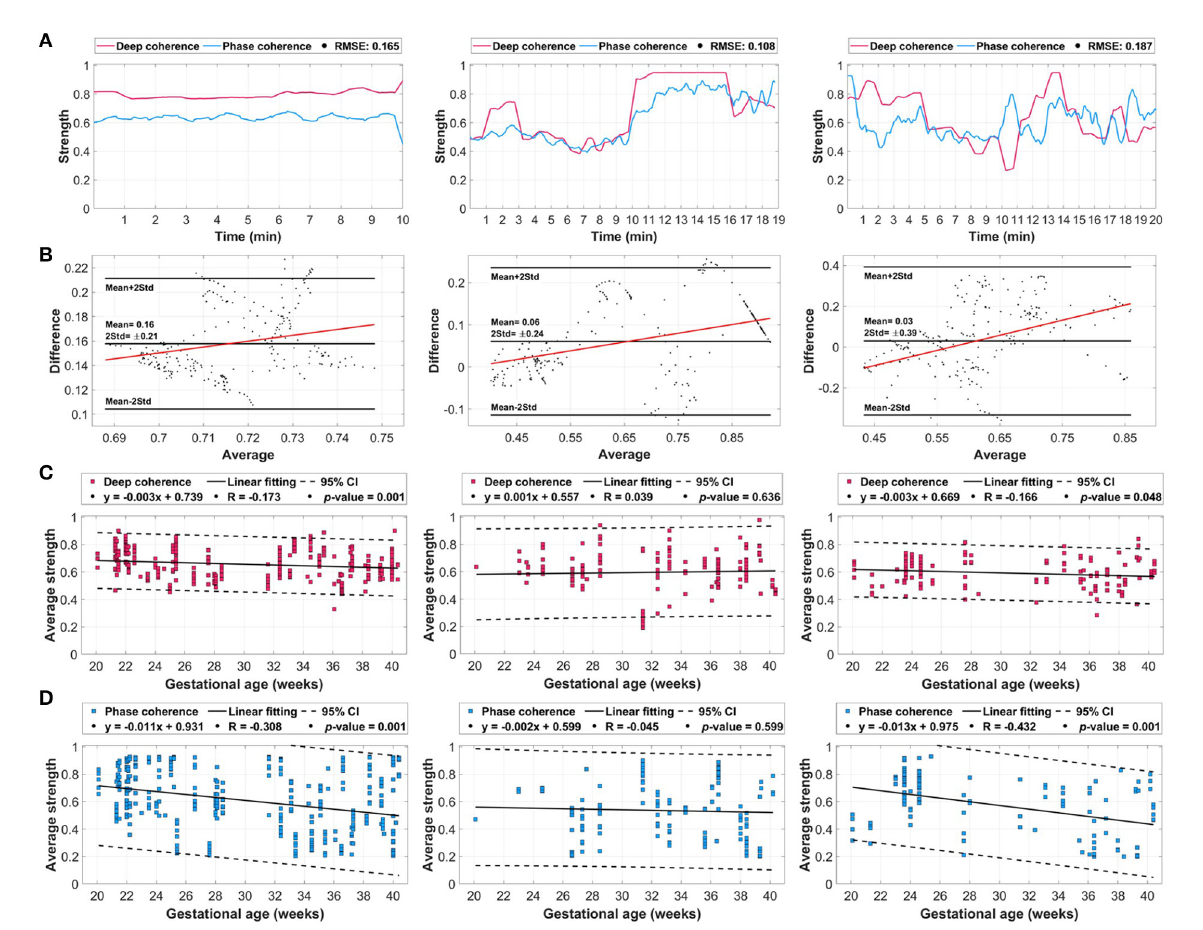
FIGURE5 The averaged deep coherence and phase coherence ( λ p ) values extracted from the whole dataset with additional evaluation with respect to gestational age. (A) The overall deep coherence and phase coherence for coupling scenarios [1:2] (left column), [2:3] (middle column), and [3:5] (right column). (B) Bland-Altman plots between the overall deep learning attention and λ p signals. (C) Deep coherence relative to gestational age in weeks. (D) Phase coherence relative to gestational age. The coupling-gestational age plots include the 95 % confidence interval (CI) and linearly fitted line